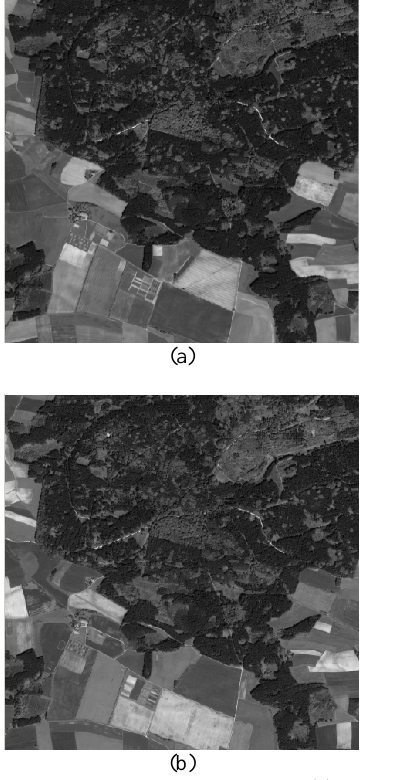
Figure 1. Cartosat-1 images of the test area. (a) Pan-2008 (b) Pan 2009 2.2 DSM/DTM/nDSM